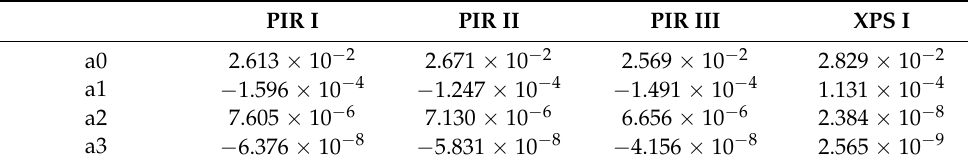
Table 5. Cubic polynomial coefficients for closed-cell foam insulation aged at 50 ◦ C.